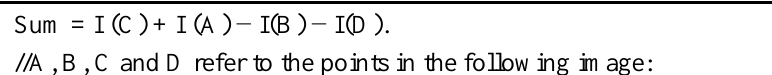
Table 5. Integral images.